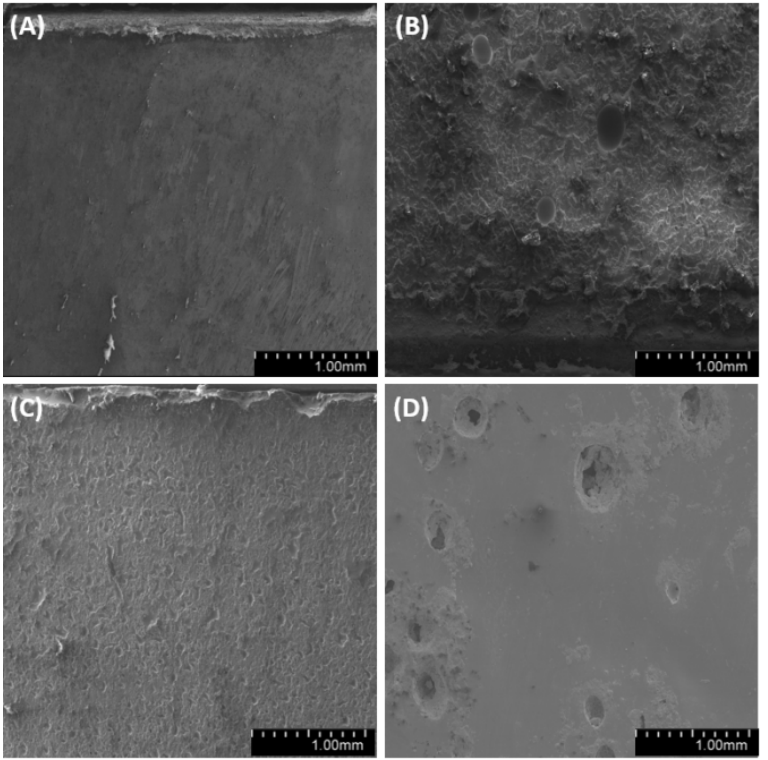
Figure 21. SEM images of the surface of samples with 70% vol. of diatoms ( A )—base deg, ( B )—base no deg, ( C )—fractionated deg, ( D )—fractionated no deg. Observations of sample fractures (Figures 22–24) have shown that the analyzed surface is mostly homogeneous. In non-degassed samples, we can observe small air bubbles located on the entire fractured surface as well as larger bubbles located in the upper section of the sample (closer to the meniscus). The fractured surface of degassed samples shows a similar degree of uniformity regardless of diatomite concentration. The samples containing fractionated diatoms feature air bubbles that are slightly bigger than those in the samples containing base diatomite.